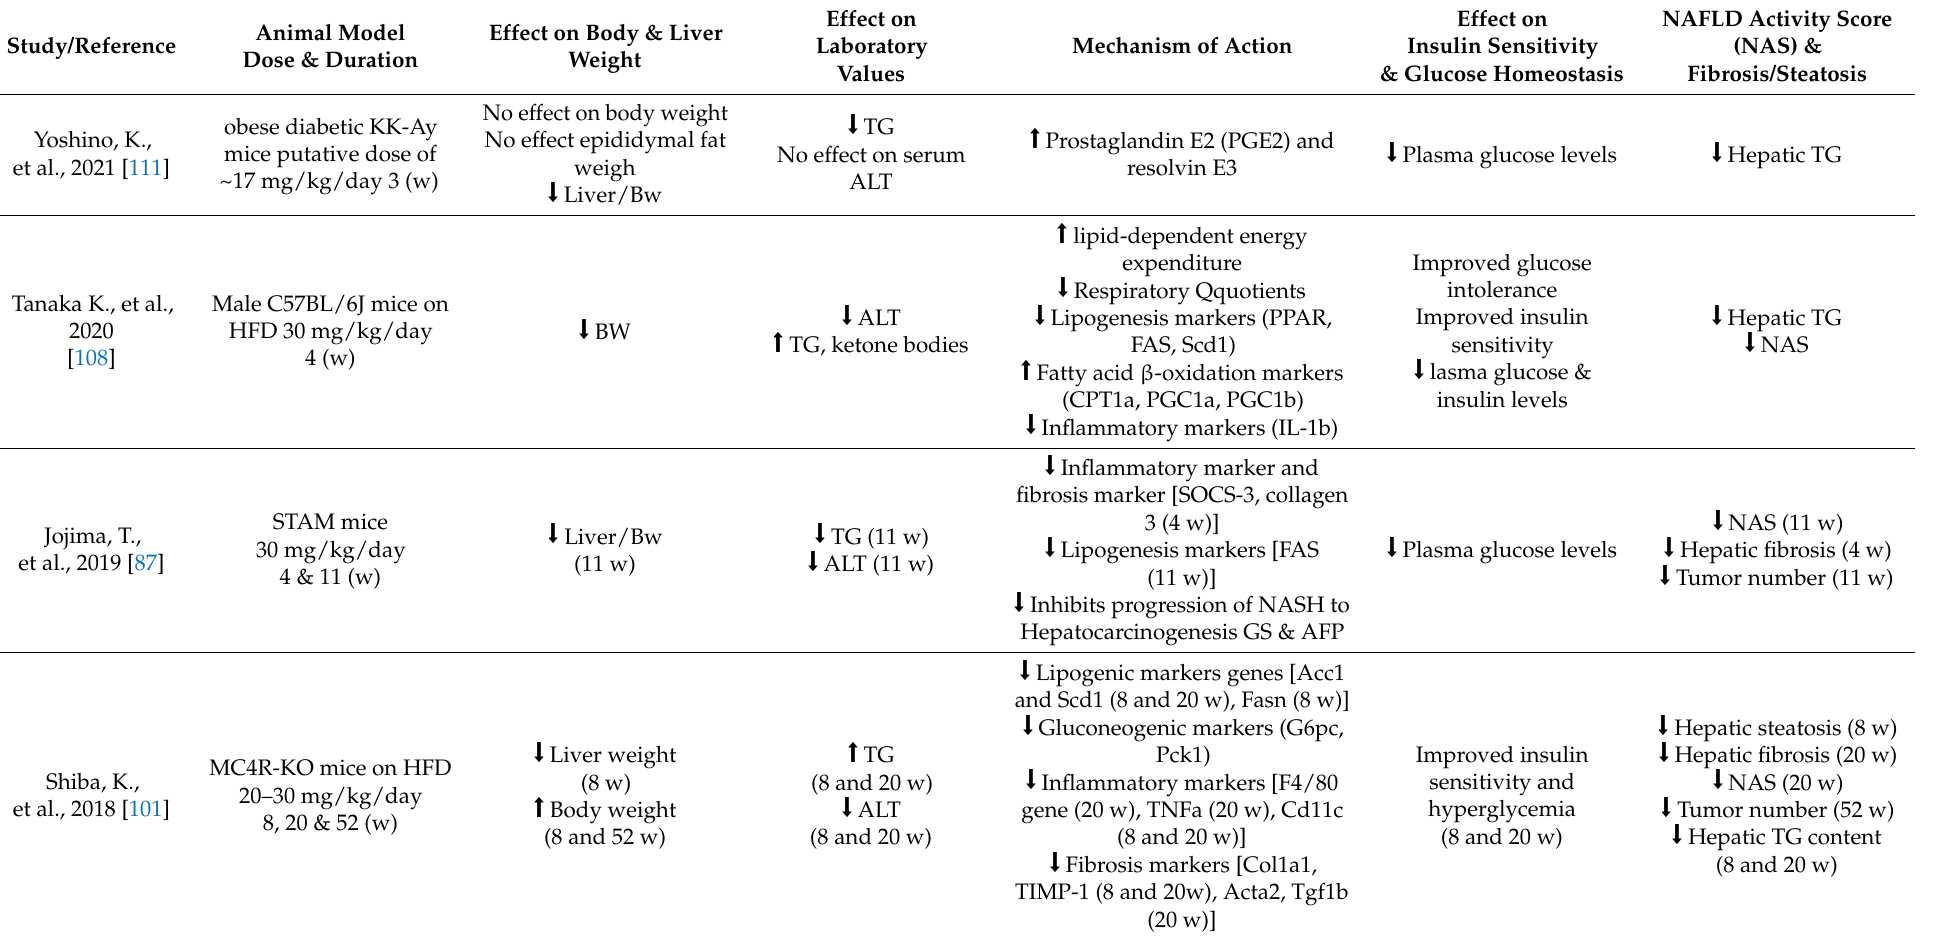
Table 1. Key animal studies regarding the impact of empagliflozin on NAFLD/NASH.